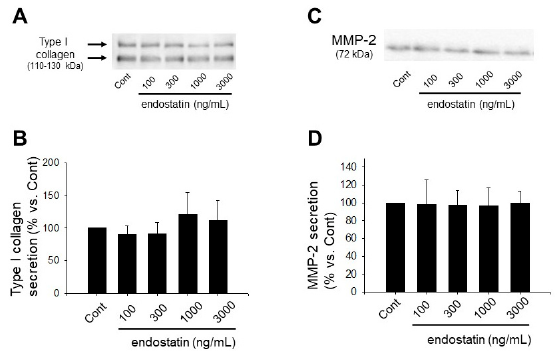
Figure 2. Endostatin had no effect on secretion of type I collagen and matrix metalloproteinase (MMP)-2 in myofibroblasts. Myofibroblasts were stimulated with endostatin (100–3000 ng/mL) or vehicle for 48 h, and culture medium was collected. Secretion of type I collagen and MMP-2 was determined by Western blotting. ( A ) Representative blot of type I collagen is shown. ( B ) Levels of secreted type I collagen were corrected by total cell protein concentration, and the normalized expression relative to Cont are shown as mean ± S.E.M. ( n = 6); ( C ) Representative blot of MMP-2 is shown. ( D ) Levels of secreted MMP-2 were corrected by total cell protein concentration, and the normalized expression relative to Cont are shown as mean ± S.E.M. ( n = 5).